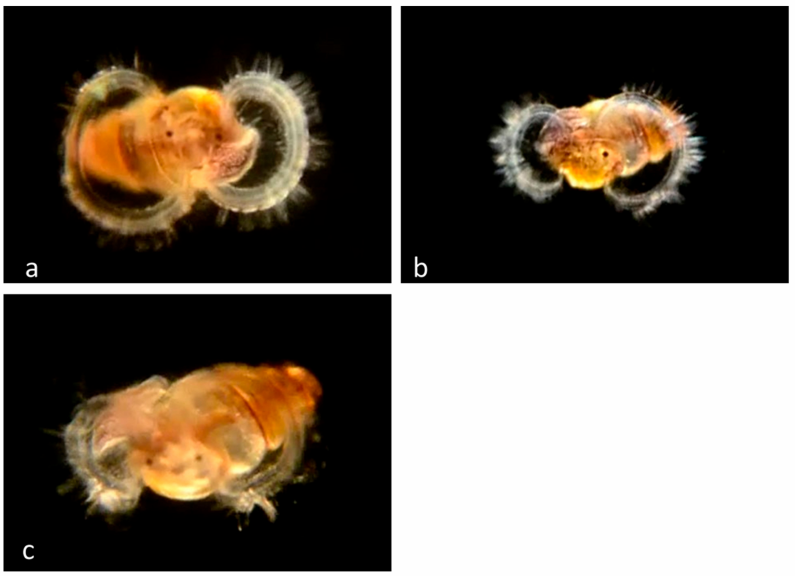
Figure 8. Family Cerithiopsidae . Cerithiopsis sp.? ( a ) Veliger BIOUG01205-H03 from off Newport Pier. ( b ) Veliger CCDB-24236-B10 from off Newport Pier. ( c ) Veliger CCDB-24722-D04 from La Profunda, Baja